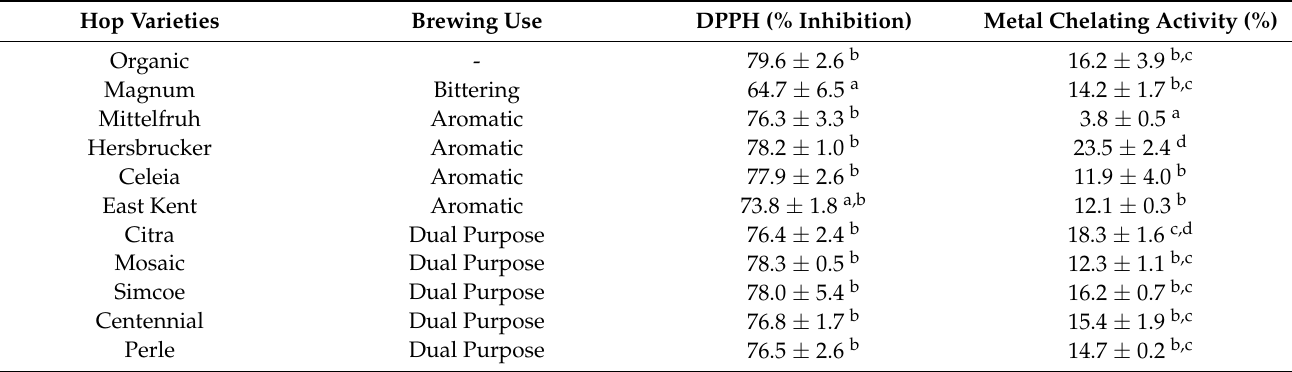
Table 5. Antioxidant Activity of Hops